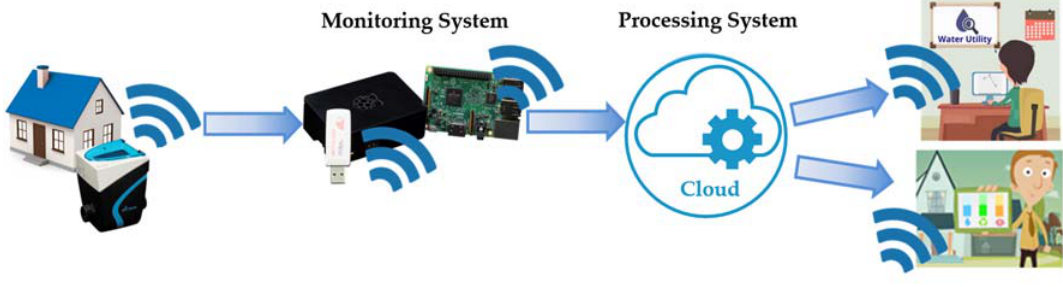
Figure 1. Flow of the water consumption data/information within the implemented